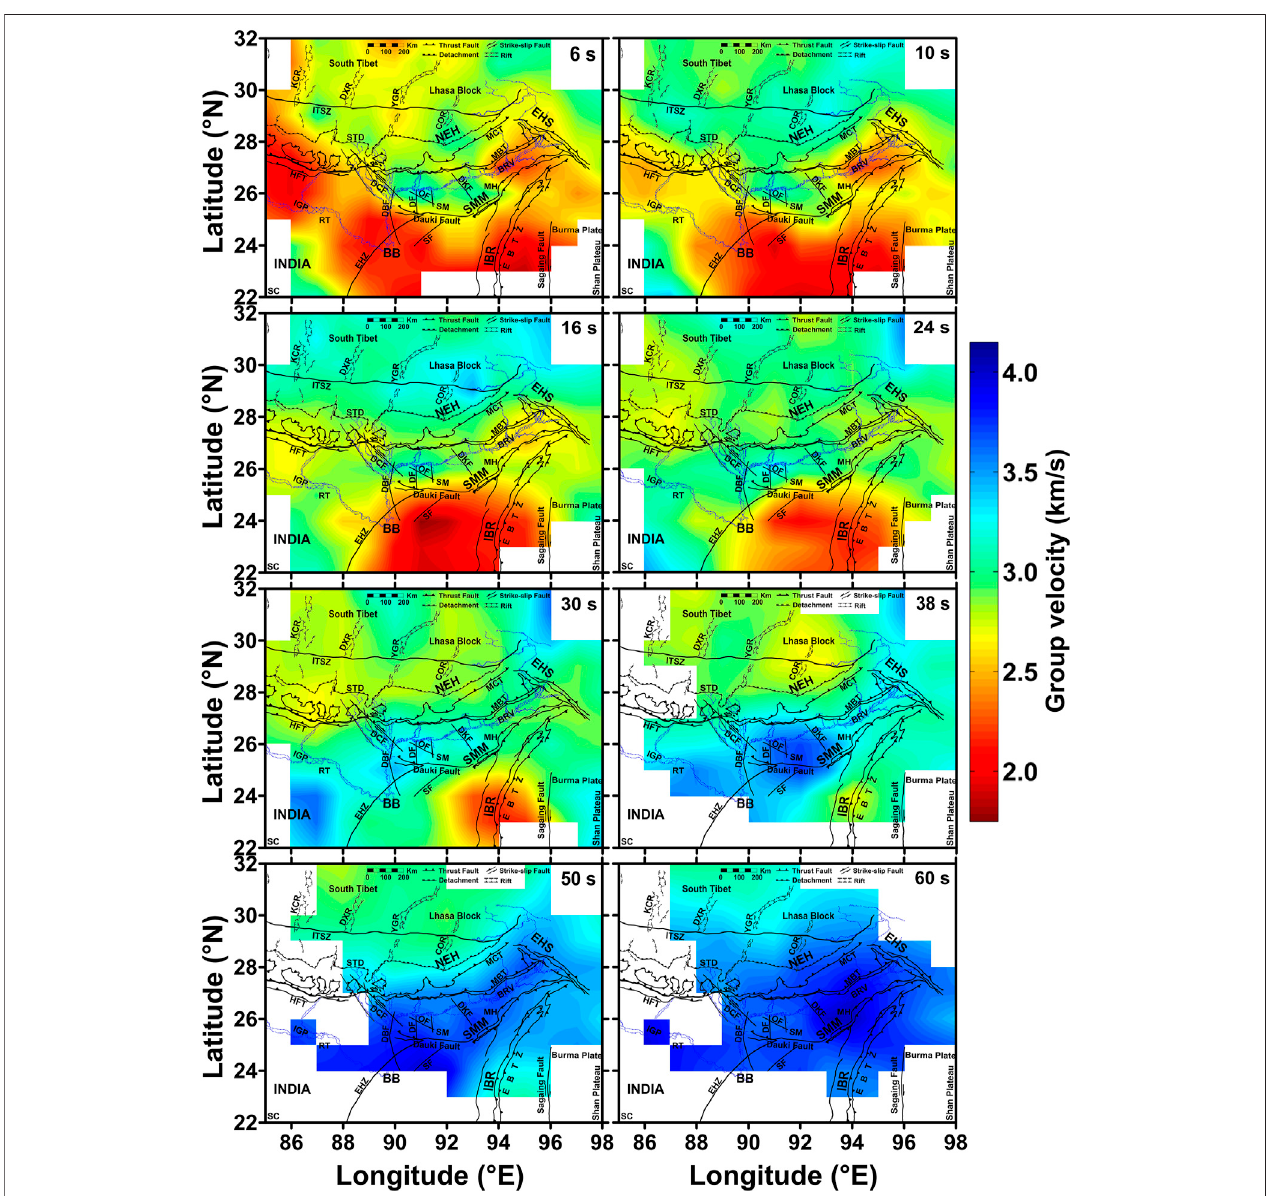
FIGURE 5 | Rayleigh wave fundamental mode group velocity tomographic images at different periods. Areas, where the resolution length of tomographic image > 200 km, are clipped and shaded white.